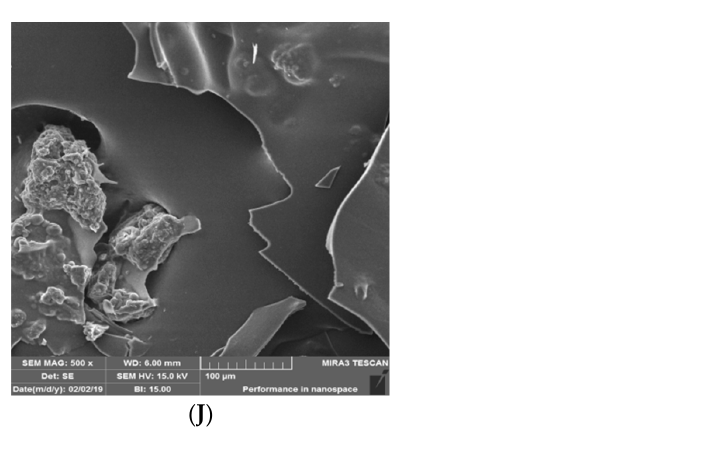
Figure 2. Scanning electron micrographs of freeze-dried encapsulated powders. ( A ): CS (50), P (50), WPI (0); ( B ): CS (0), P (50), WPI (50); ( C ): CS (0), P (0), WPI (100); ( D ): CS (50), P (0), WPI (50)); ( E ) CS (100), P (0), WPI (0); ( F) : CS (16.7), P (66.7), WPI (16.7); ( G ): CS (0), P (100), WPI (0); ( H ): CS (16.7), P (16.7), WPI (66.7); ( I ): CS (66.7), P (16.7), WPI (16.6); ( J ): CS (33.3), P (33.3), WPI (33.3). Table 4. Chemical properties of encapsulated powder.